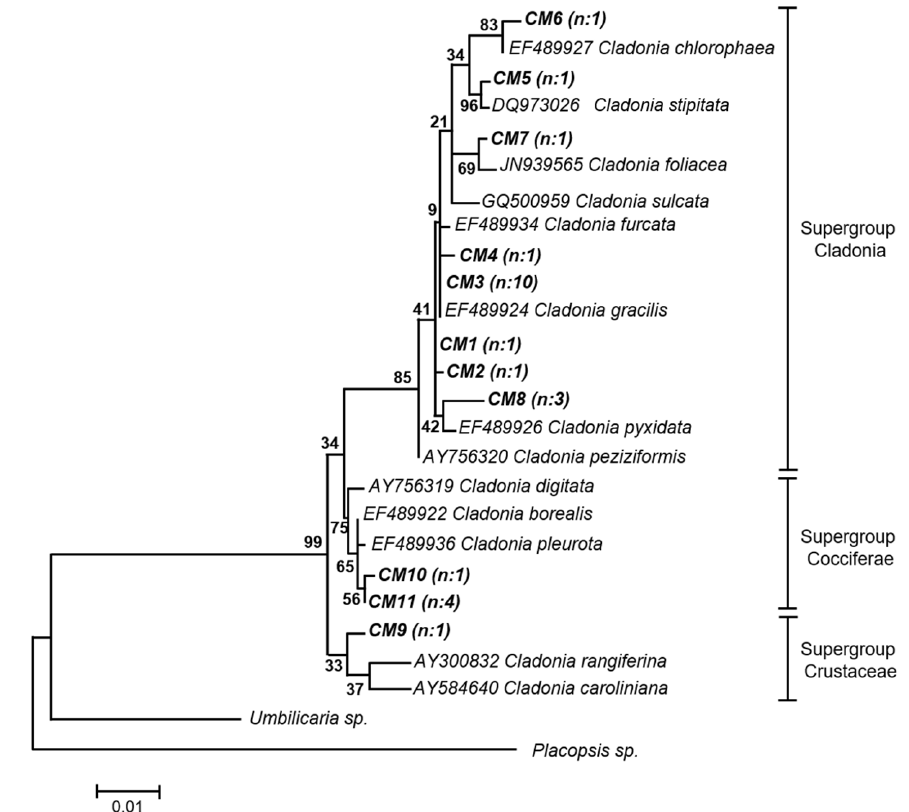
Figure A2. Phylogenetic tree of Cladonia operational taxonomic units (OTUs) by Bayesian inference. Bootstrap support values are indicated at the nodes and the bar indicates the genetic distance. The mycobionts from this study, named as CM followed by a number, are shown in bold. The number of specimens per haplotype is shown in parentheses. The division of the species into supergroups corresponds to Stenroos et al. [73]. Umbilicaria sp . (accession number FN186084) and Placopsis sp . (accession number AY212845) sequences were used as outgroups.